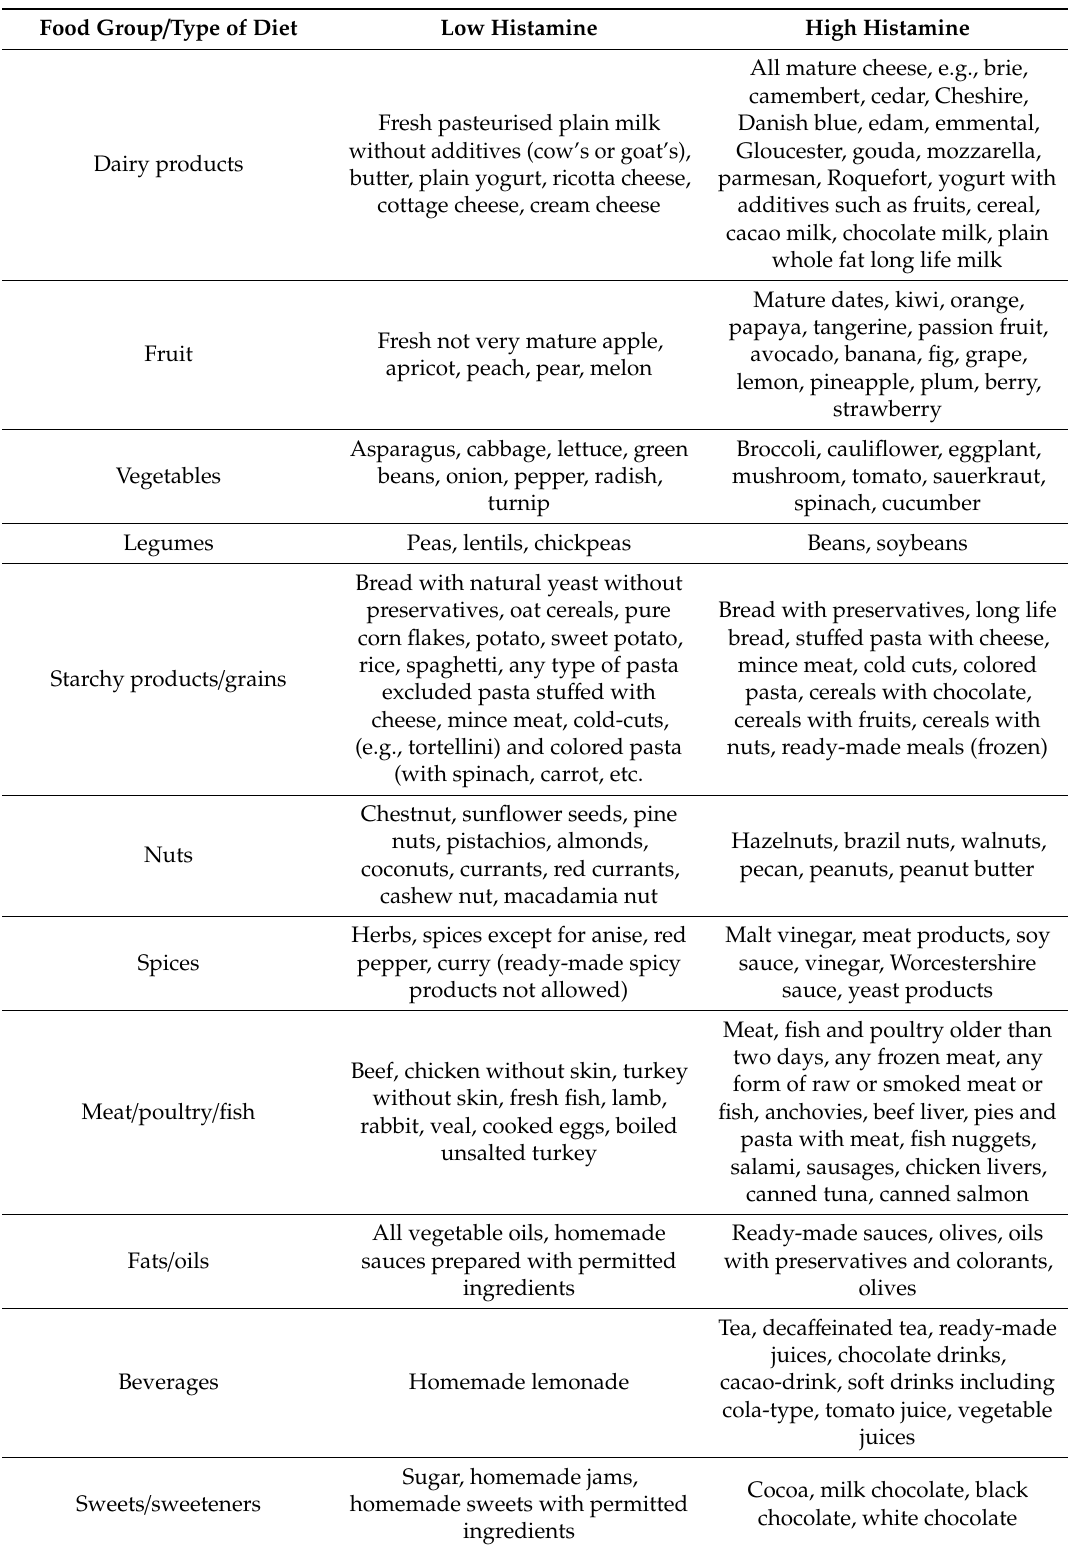
Table 1. Food ranking in low and high histamine content. Food Group / Type of